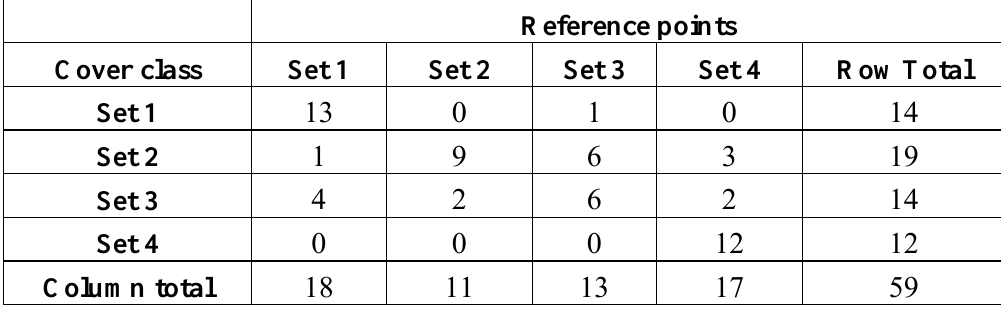
Table 1B. Sample of classification result error matrix of the uncorrected image (image 2 , Milwaukee urban areas.